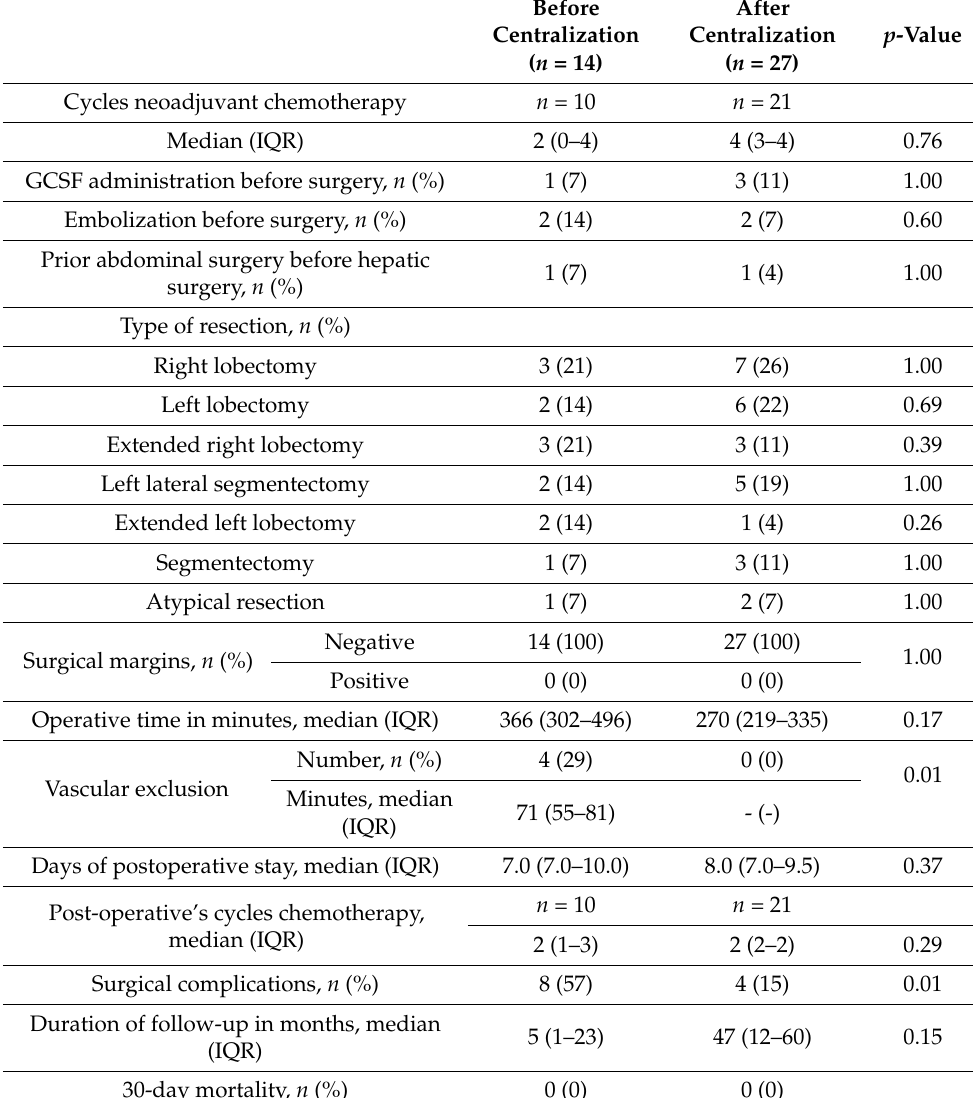
After Before p -Value Centralization Centralization ( n = 27) ( n = 14)